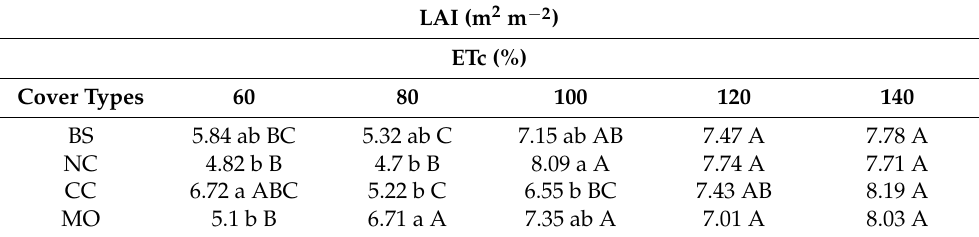
Table 3. Mean leaf area index (LAI) for sorghum, for bare soil conditions (BS), natural cover (NC), coconut coir (CC), and moringa (MO), and for irrigation depths of 60%, 80%, 100%, 120%, and 140% of ETc.